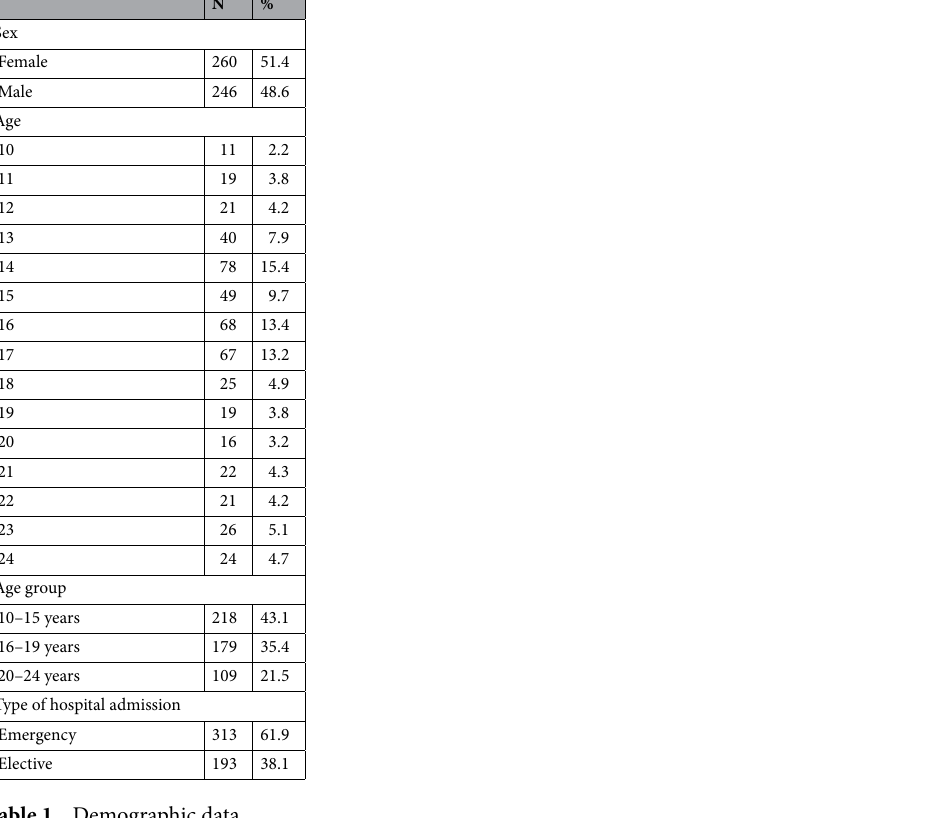
Table 1. Demographic